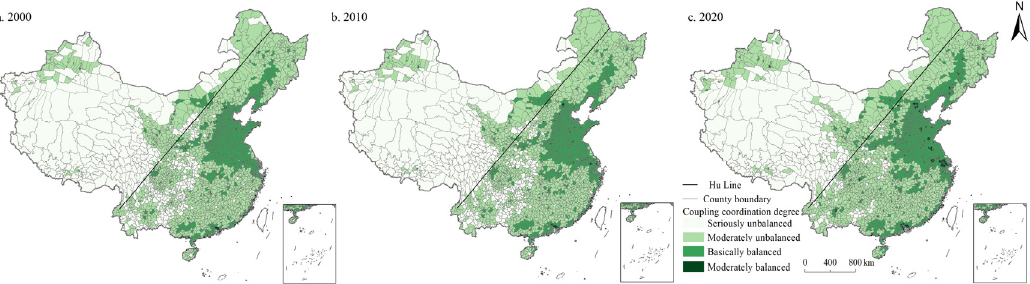
Figure 6. Spatial distribution of coordination degree of PSI and ESI in China during 2000–2020.